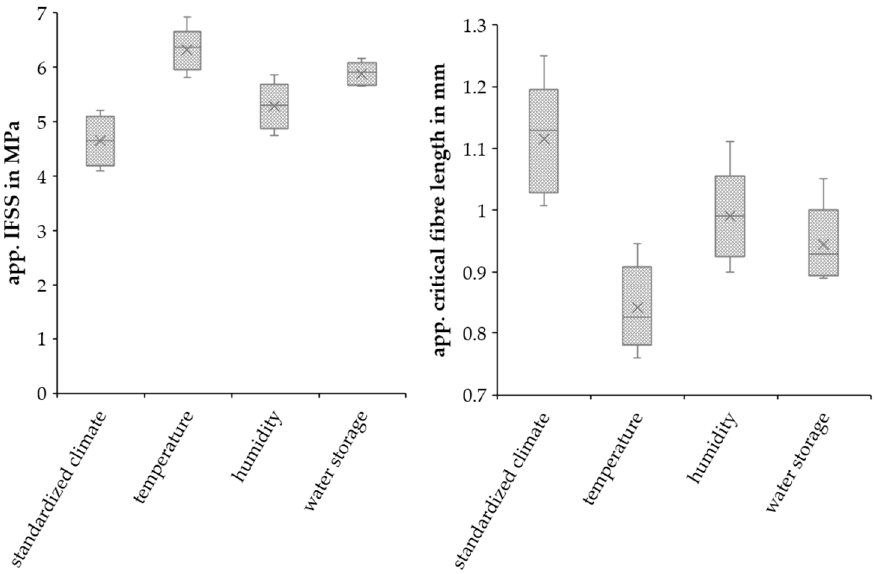
Figure 10. Apparent IFFS and critical fiber length of the RCFs with aged matrix.